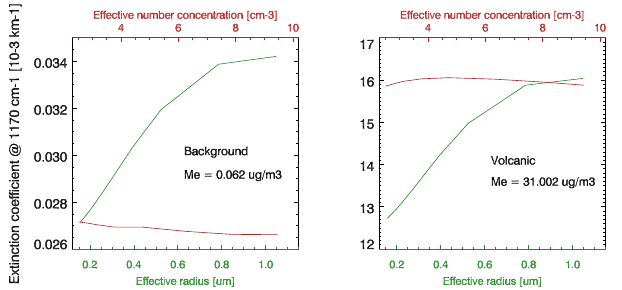
Figure 5. Extinction coefficient at 1170cm − 1 (maximum extinc- tion, ME) as function of the effective radius r e (green line) and ef- fective number concentration N e (red line), for fixed sulfate aerosol effective mass volume concentrations M e (0.062µgm − 3 : back- ground conditions – left panel; 31.002µgm − 3 : volcanically en- hanced conditions – right